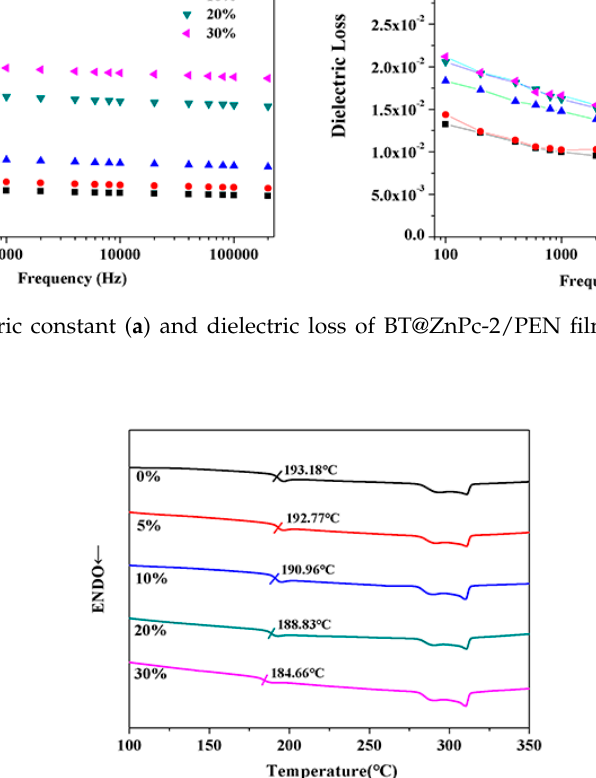
Figure 9. DSC curves of BT@ZnPc-2/PEN films with 0, 5, 10, 20, and 30 wt% of BT@ZnPc-2.